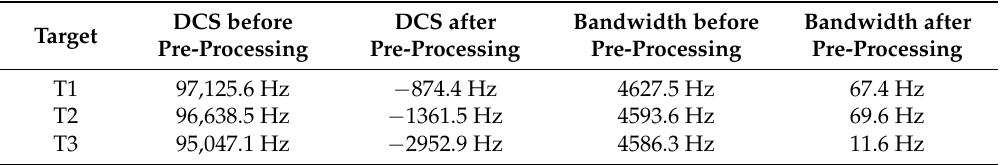
Table 4. DCS and bandwidth for moving